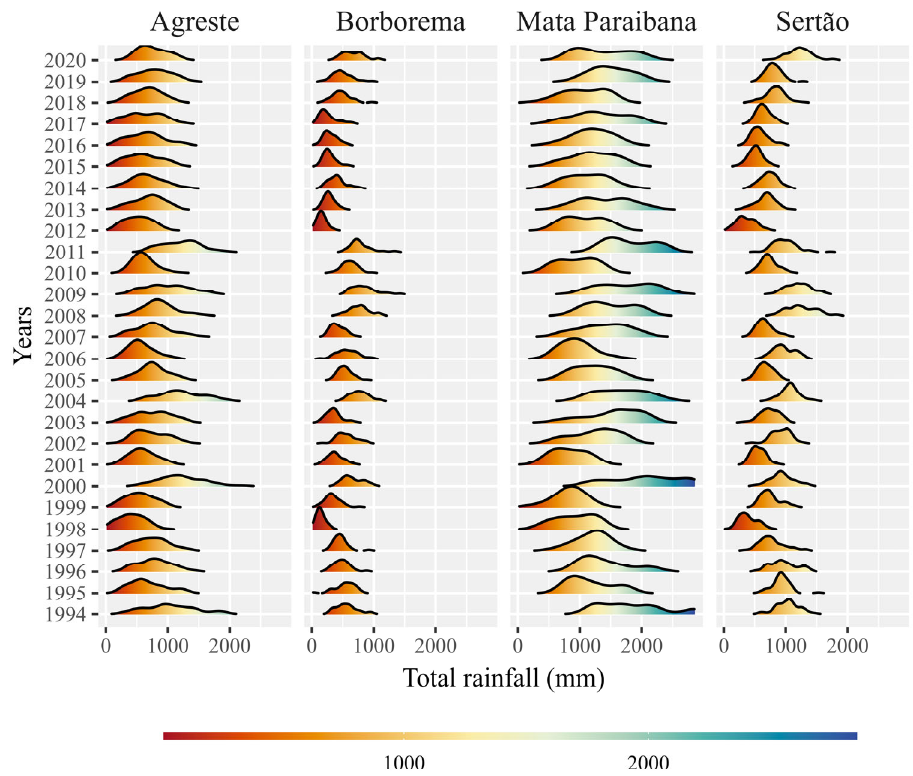
Figure 9. Density of the total annual rainfall for the Paraíba mesoregions from 1994 to 2020.